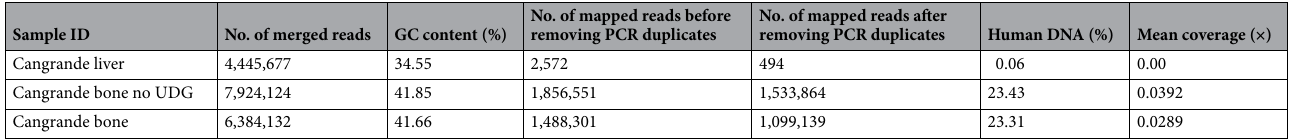
Table 1. Exploratory WGS analysis, indicating the human sequence content in three DNA samples. The table shows the number of sequenced reads, the GC percentage, the number of mapped reads before and after removing PCR duplicates, the percentage of fragments mapped to the human reference genome, and the average coverage of the genome.